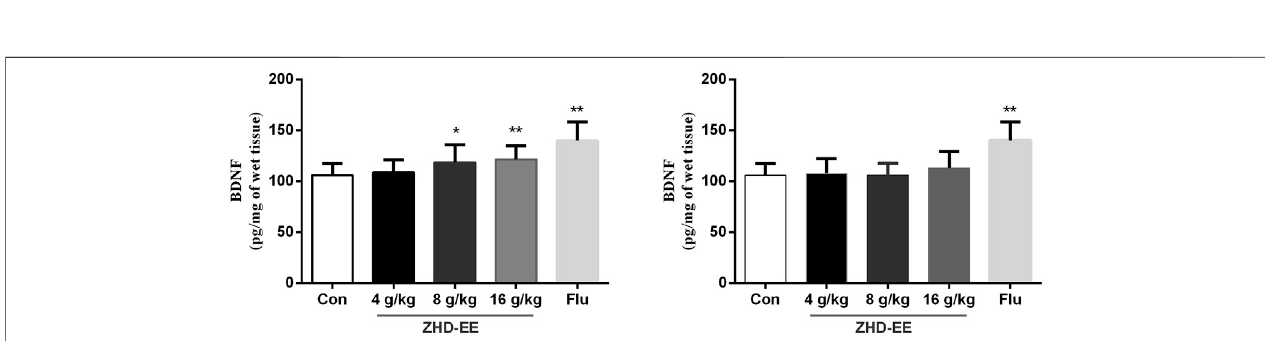
FIGURE2| EffectsofZHD-EEandZHD-WEontheBDNFlevelsinthehippocampus.Thedataarepresentedasthemean±SD( n =10).ZHD-EE:ethanolextractof ZHD; ZHD-WE: water extract of ZHD.